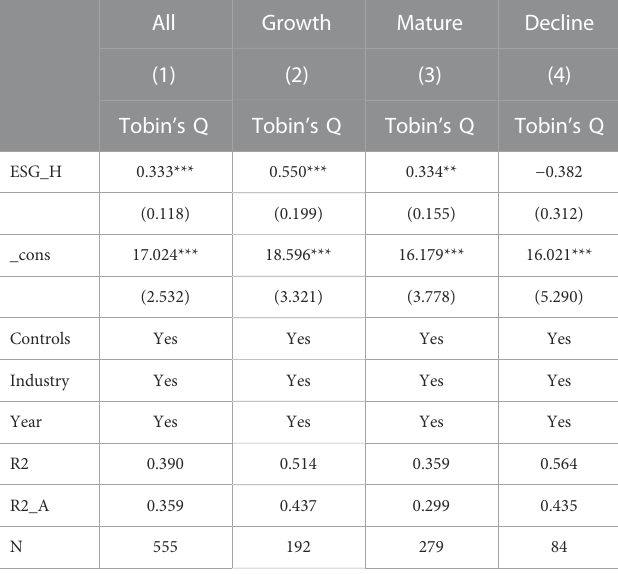
TABLE 13 Replacement of dependent variables.